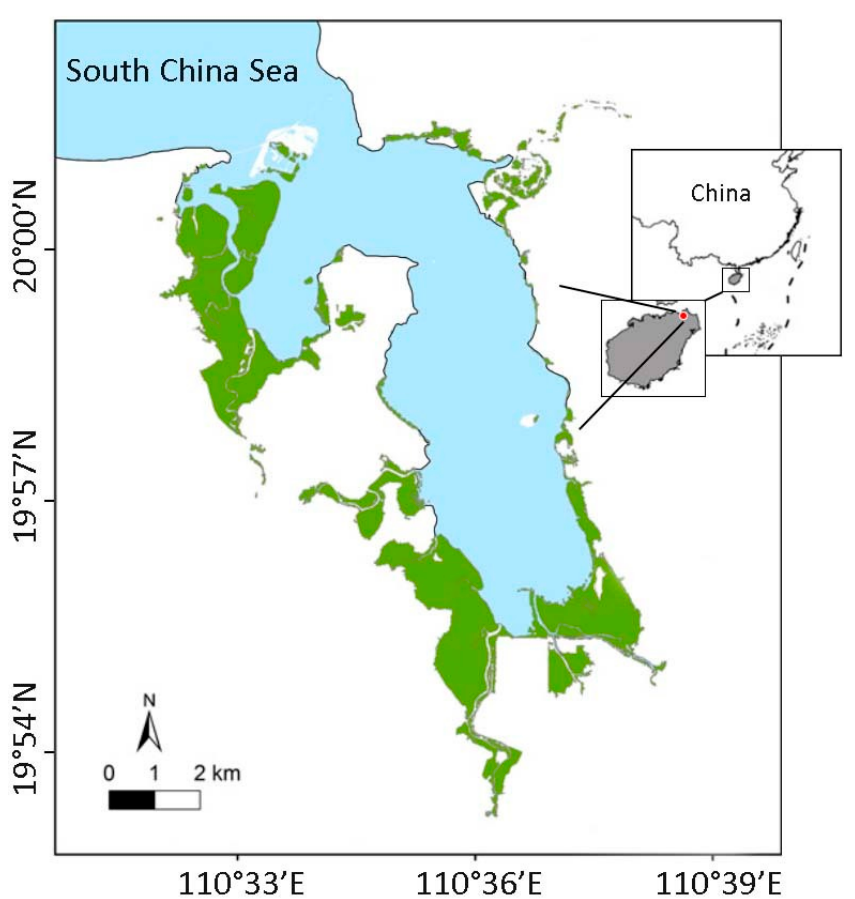
Figure 1. Map of Dongzhaigang Bay, Hainan Province, China, showing the distribution of mangrove trees around the bay (green color); and the location of Dongzhaigang Bay in the northeast of Hainan (1st insert), in the south of China (2nd insert).